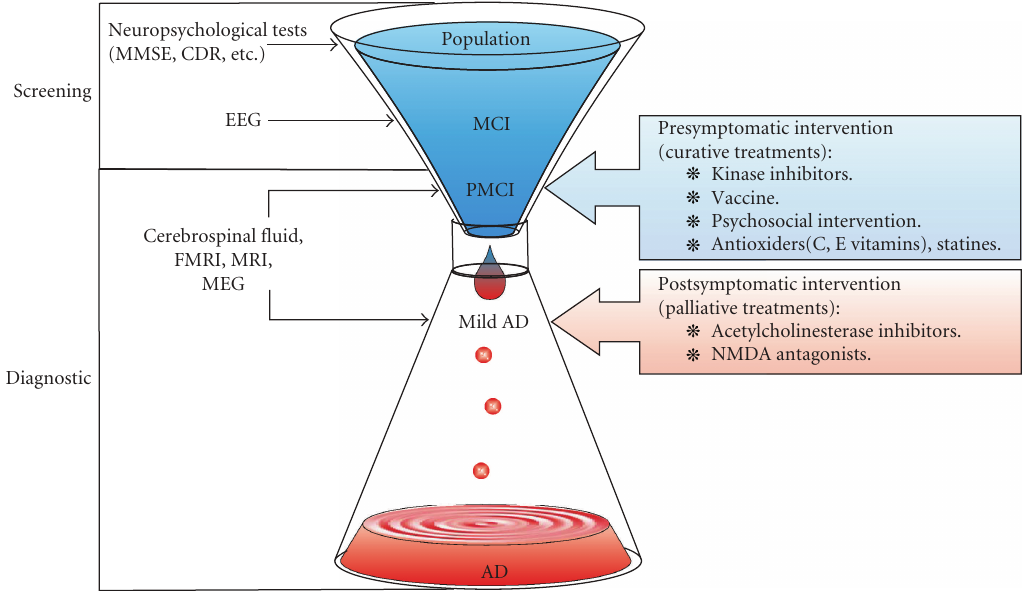
Figure 2: EEG may be used as a screening tool for early-stage AD, since EEG recording technology is inexpensive and available in most hospitals. At an early stage of AD, presymptomatic interventions (curative treatments) may be investigated. However, EEG is not yet a reliable diagnostic tool: the specificity of EEG needs to be improved.